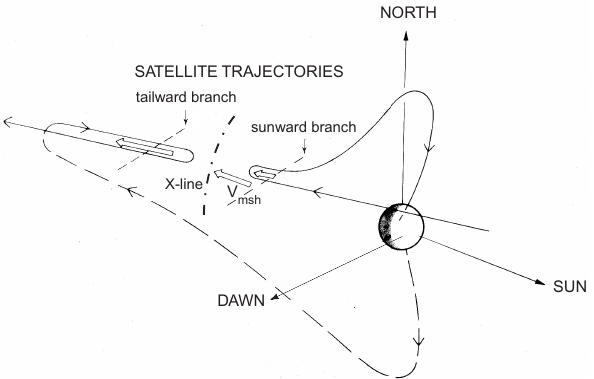
Fig. 3. A sketch that illustrates reconnection between a tailward stretched magnetospheric field line in the Northern Hemisphere past dawn with an oppositely directed magnetosheath field line. The light arrows indicate plasma flow. The orientation of the X-line is shown by the dot-dashed line. Spacecraft crossings of the tail- ward and sunward branches are schematically indicated. The ge- ometry shows the case with 180 ◦ shear. For magnetosheath fields not anti-parallel to the magnetosphere field, the X-line is tilted more obliquely. Figure adapted from Gosling et al. (1986).